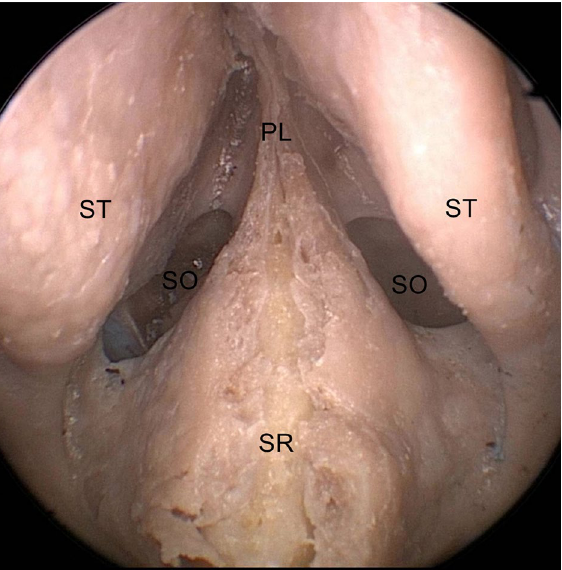
Figure 1. Exposure of the sphenoidal sinus anterior wall in endoscopic view. ST superior turbinate, PL perpendicularis lamina, SR sphenoidal rostrum, SO Sphenoid ostia.